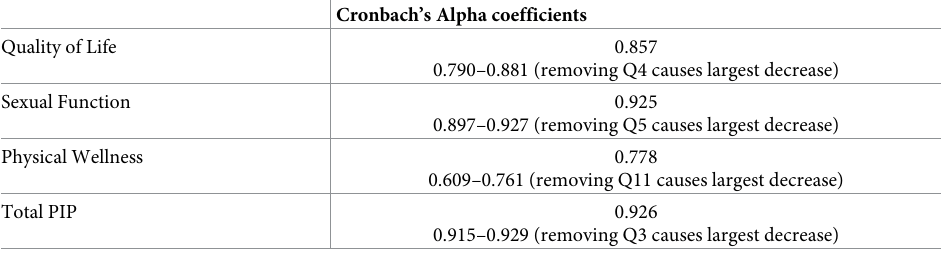
Table 5. Cronbach’s alpha reliability coefficients for PIP score, QoL, SF, and PW to demonstrate good item- domain/total instrument